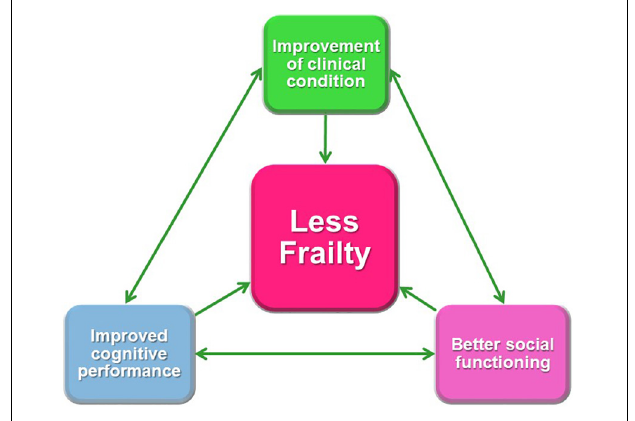
FIGURE 3 | Relationship between frailty (grip strength), cognitive performance, and social